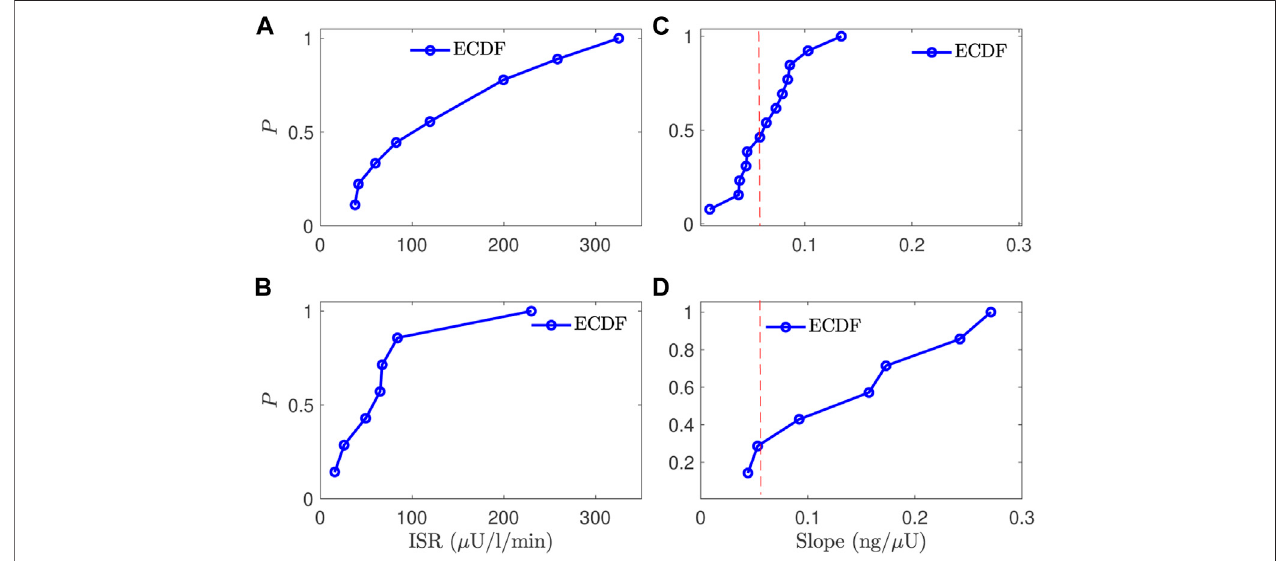
FIGURE7| AcomparisonbetweenthenormalandCFRDsubjects,usingtheprobabilityofempiricalcumulativedistributionfunction(ECDF),fortheISRvalue (A,B) evaluatedattheglucosevalueof140 mg/dl(horizontal)andtheslopebetweenISRandCSR (C,D) ,theverticalaxisistheprobability(ECDF);theexpectedvalueis0.056 for the slope (red line (C,D)